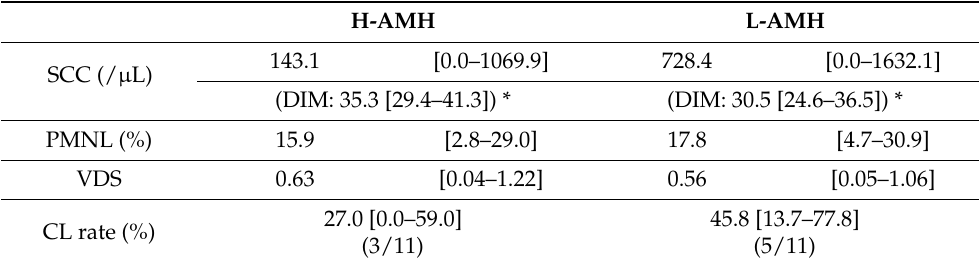
Table 5. Results of somatic cell count (SCC) in milk and postpartum reproductive traits for recovery of uterus and ovarian function at D28.